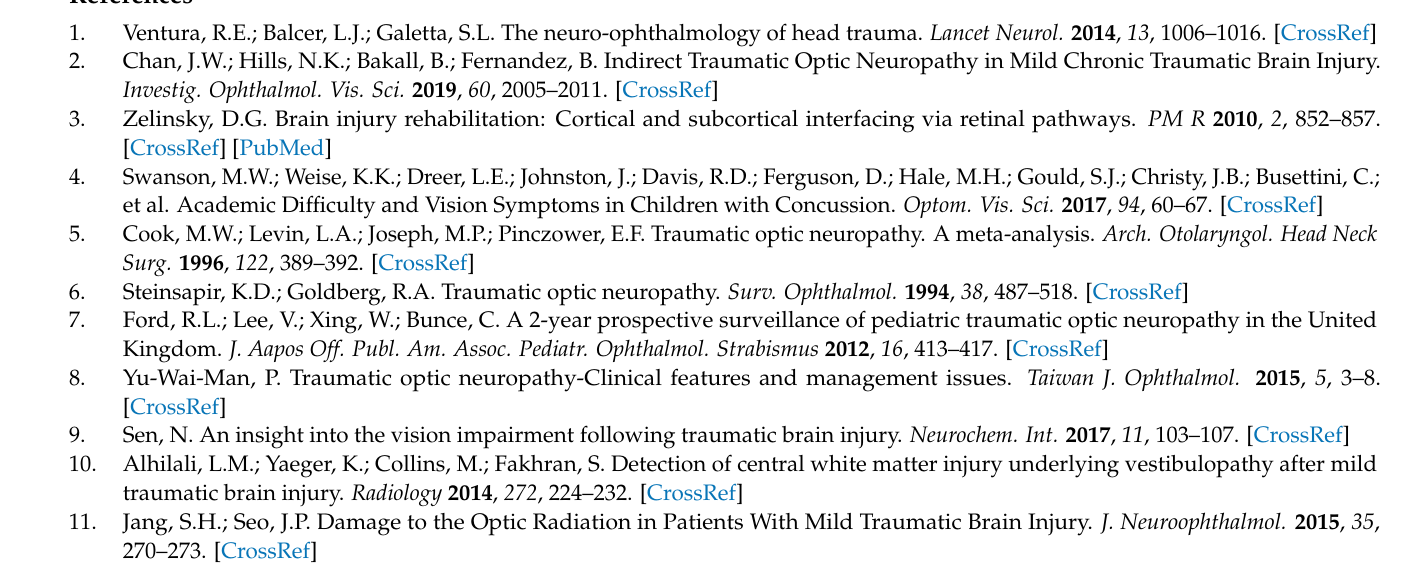
Table S1: Data transformations used to pass normality, Figure S2: Secondary antibody-only control for brn3a immunohistochemistry, Table S2: Weight and morbidity statistical results, Table S3: Be- havioral statistical results, Table S4: Comparison of left vs. right hemisphere structures, Table S5: Immunofluorescence statistical results, Figure S3: Larger images of IBA-1-labeled cells, Table S6: Western blotting statistical results, Figure S4: Representative raw Western blot films at 7 DPI, and Figure S5: Representative raw Western blot films 30